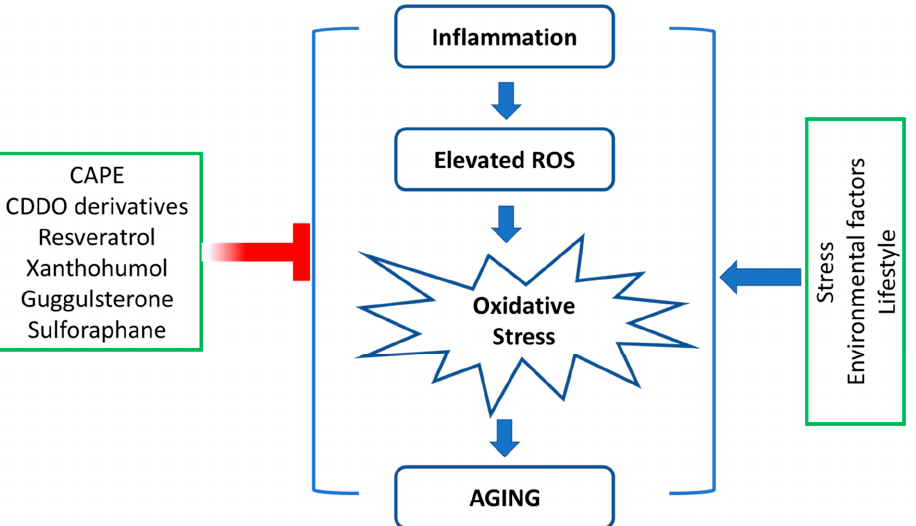
Figure 3. Phytochemicals inhibit OS-induced aging. Imbalance between the free radicals and antioxidants seen under inflammatory conditions leads to OS contributing to the process of aging. Several environmental factors and components of lifestyle play a significant role in increasing ROS levels, leading to oxidative stress-induced aging. Many pharmacological drugs have been shown to induce changes in autophagy and ROS, contributing to their health benefit; however, natural compounds are continuously being investigated because they are linked to other health benefits. Although overwhelm- ing evidence in the literature supports that the discussed natural compounds have the potential for antiaging effects, further studies, including pre-clinical and clinical, need to be performed to understand and identify specific drug targets and doses for therapeutic intervention in antiaging effects. Author Contributions: Conceptualization and supervision, X.W.; validation, visualization, and writing—review and editing, Y.K., S.R., and X.W.; writing—original draft, E.T., Y.K., K.Z., L.C., B.C.N., S.R., X.W. All authors have read and agreed to the published version of the manuscript. Funding: This research received no external funding. Institutional Review Board Statement: Not applicable. Informed Consent Statement: Not applicable. Data Availability Statement: Not applicable. Conflicts of Interest: The authors declare no conflict of interest. References 1. Harraan, D. Aging: A Theory Based on Free Radical and Radiation Chemistry ; University of California: Berkeley, CA, USA, 1955.